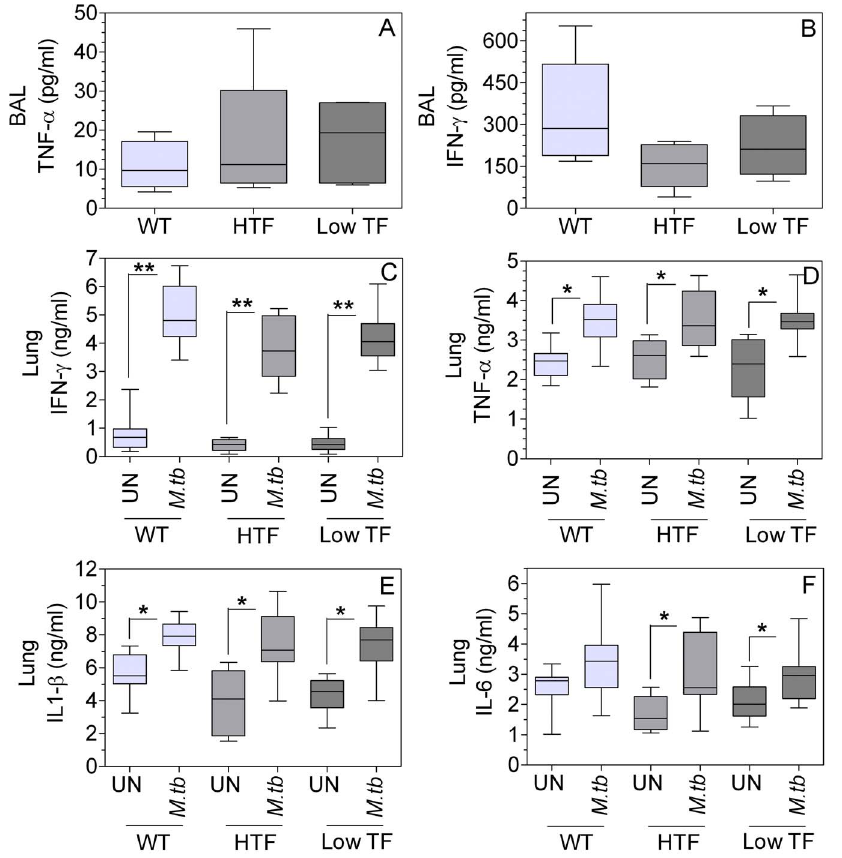
Figure 4. TF deficiency does not affect the proinflammatory cytokine response to M.tb infection. Cytokine levels in BAL fluids ( A, B ) and lung homogenates ( C–F ) were measured in ELISA. ( A ) TNF- a levels in BAL; ( B ) IFN- c levels in BAL; ( C ) IFN- c levels in lung homogenates; ( D ) TNF- a levels in lung homogenates; ( E ) IL-1-ß levels in lung homogenates; ( F ) IL-6 levels in lung homogenates. UN, uninfected; M.tb , infected with live H37Rv. (n 5 8–19 per group). * denotes significantly different from uninfected controls. (p , 0.05) as obtained by one-way ANOVA and Tukey